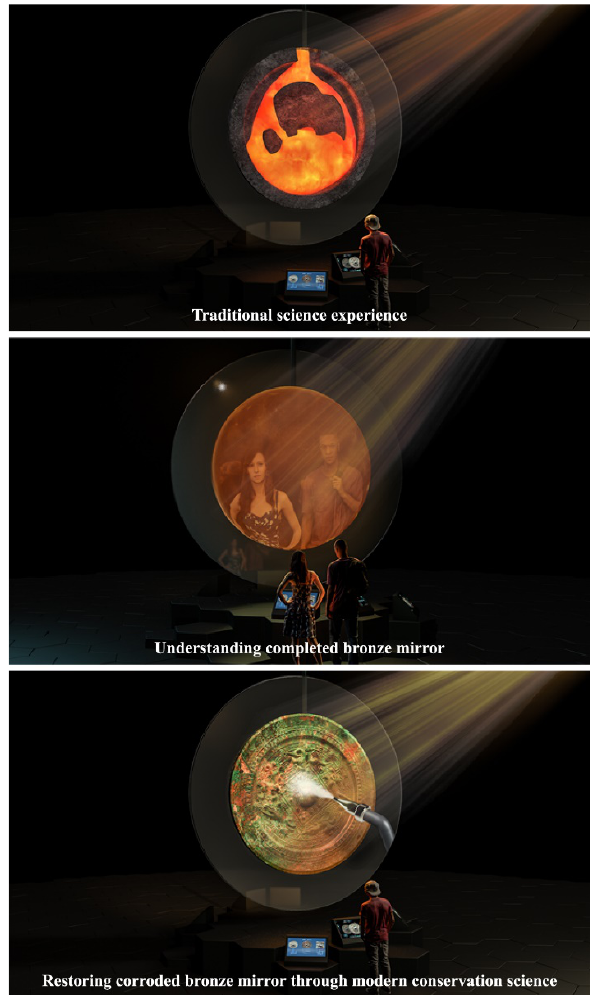
Figure 2. Media art scenarios of the bronze mirror